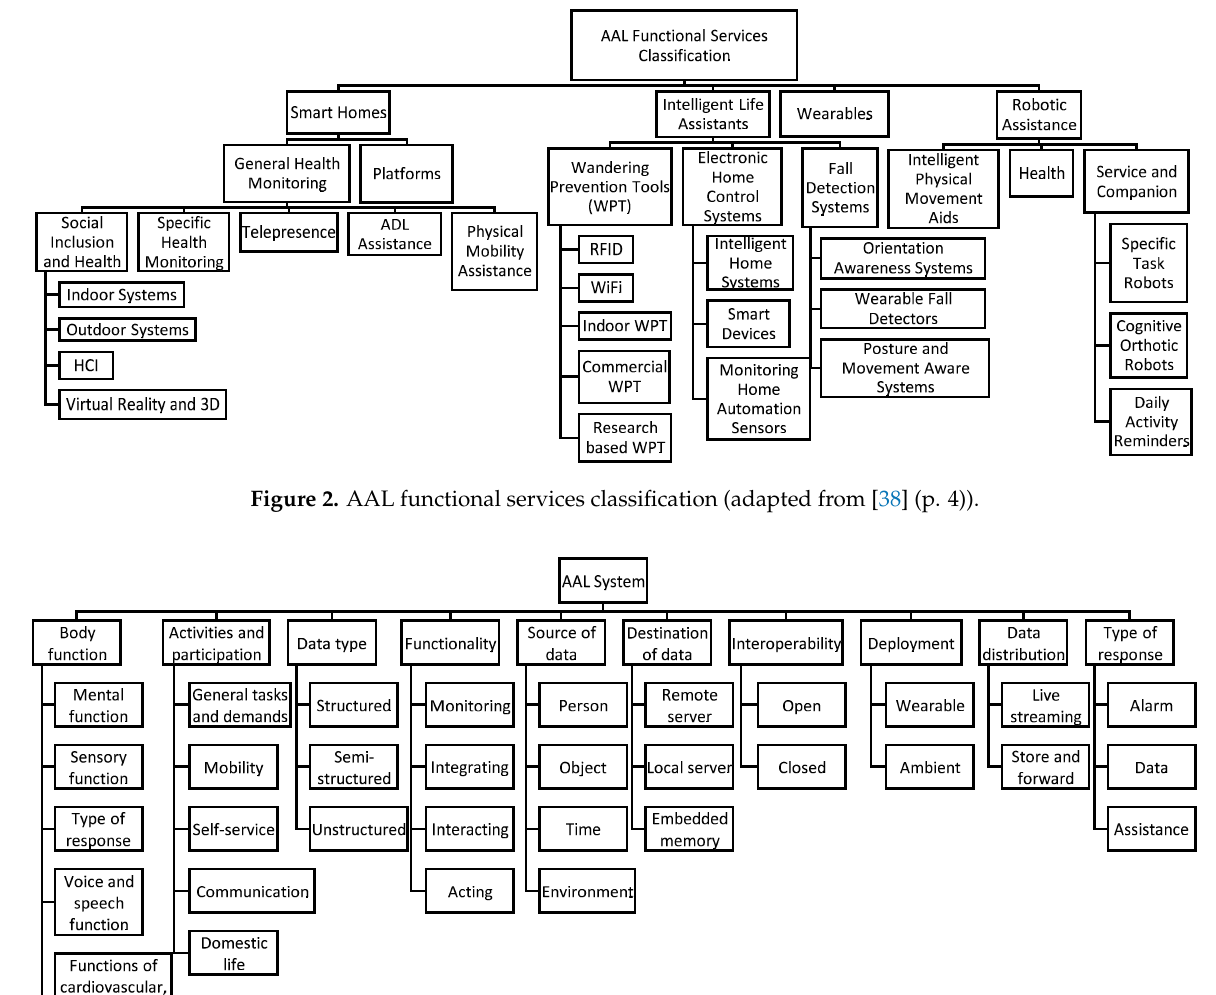
Figure 3. Data quality-oriented AAL taxonomy.